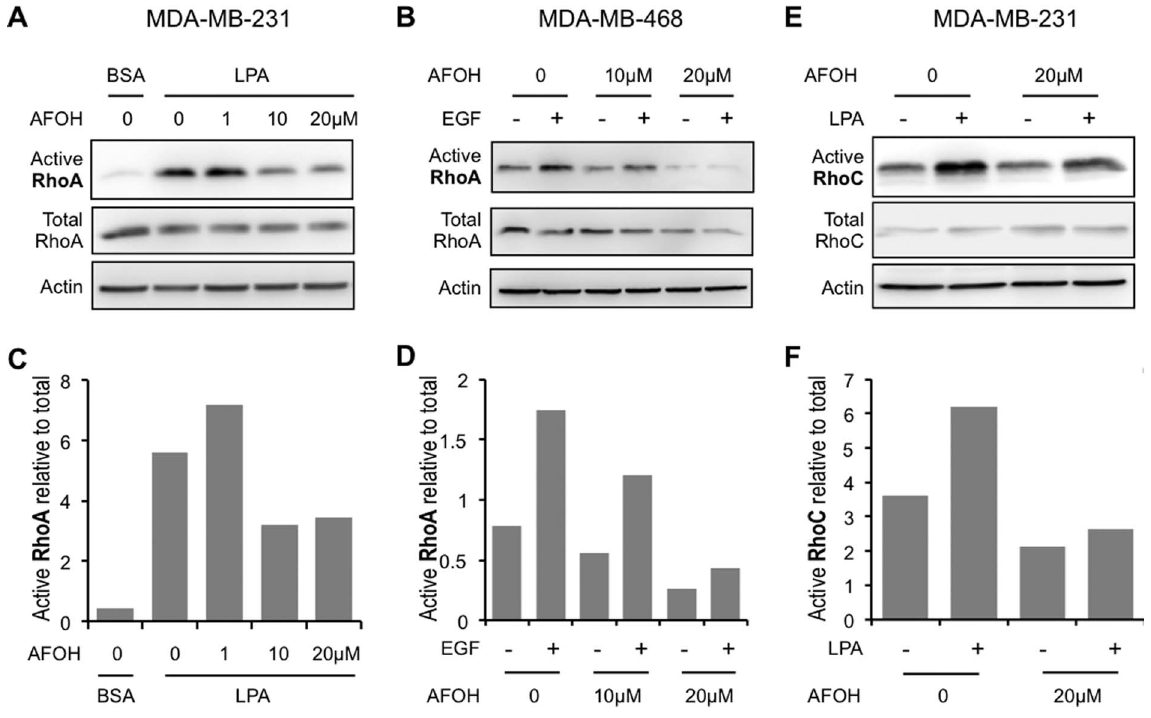
Figure 6. AFOH blocks RhoA and RhoC activation in response to LPA or EGF. MDA-MB-231 cells (A, C, E and F) or MDA-MB-468 cells (B and D) were treated with AFOH at the indicated concentration for 3 days, plated on collagen I coated dishes in the presence of AFOH and then treated with 100 nM LPA (A and E, quantified in C and F) or 5 ng/ml EGF (B, quantified in D) for 5 min prior to harvesting for RhoA (A–D) or RhoC (E, F) activity assays. Rho activity assays are representative from at least three separate experiments.